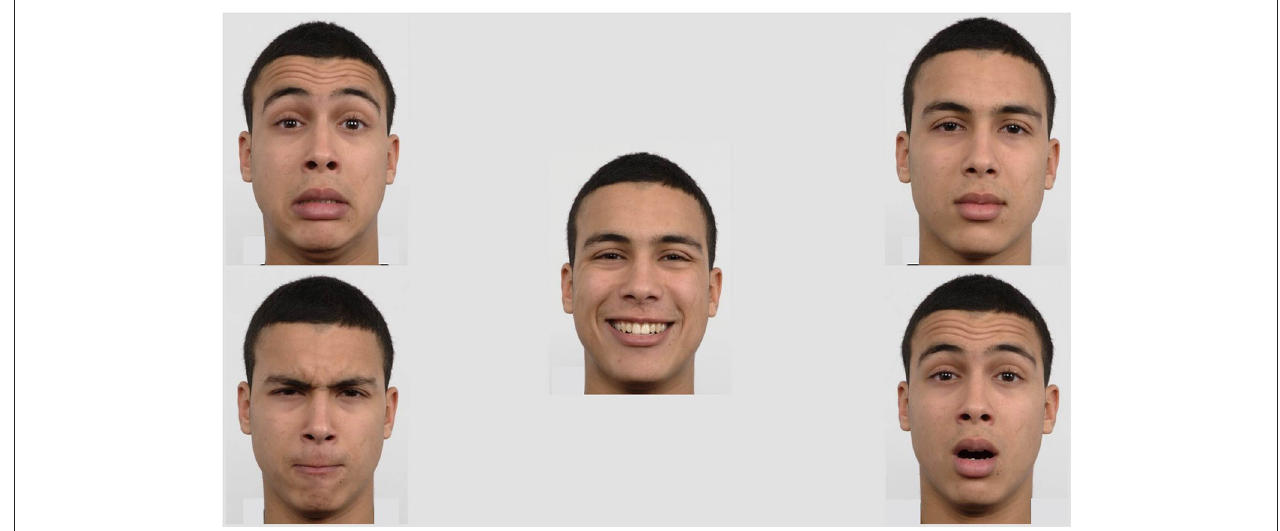
FIGURE 1 | Exemplary stimulus: The five emotional expressions (happy, neutral, surprised, angry, and scared) of one identity were presented simultaneously on five different positions (center, top right, bottom right, bottom left, and top left).